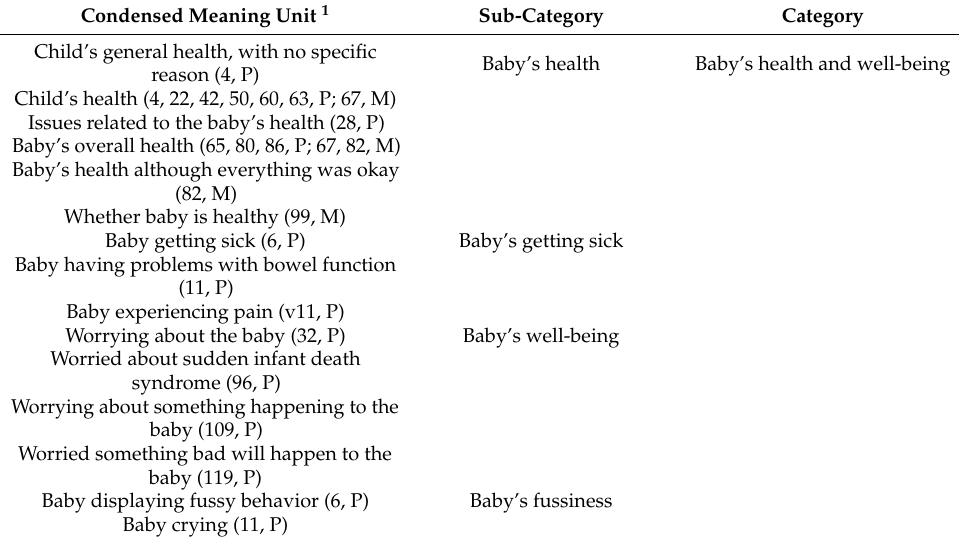
Table 1. An example of how the data were condensed and abstracted, using the shared fears and concerns expressed by both primiparous and multiparous